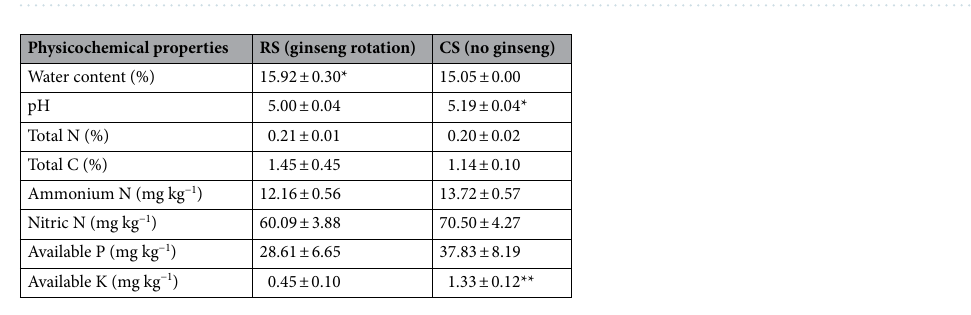
Table 1. Comparison of physicochemical properties of 10-year post-ginseng rotation soil (RS) and soil in which no ginseng was grown (CS) before ginseng planting. Mean ± SE (n = 4) data shown. *Statistically significant difference at P < 0.05; ** P < 0.01 (T